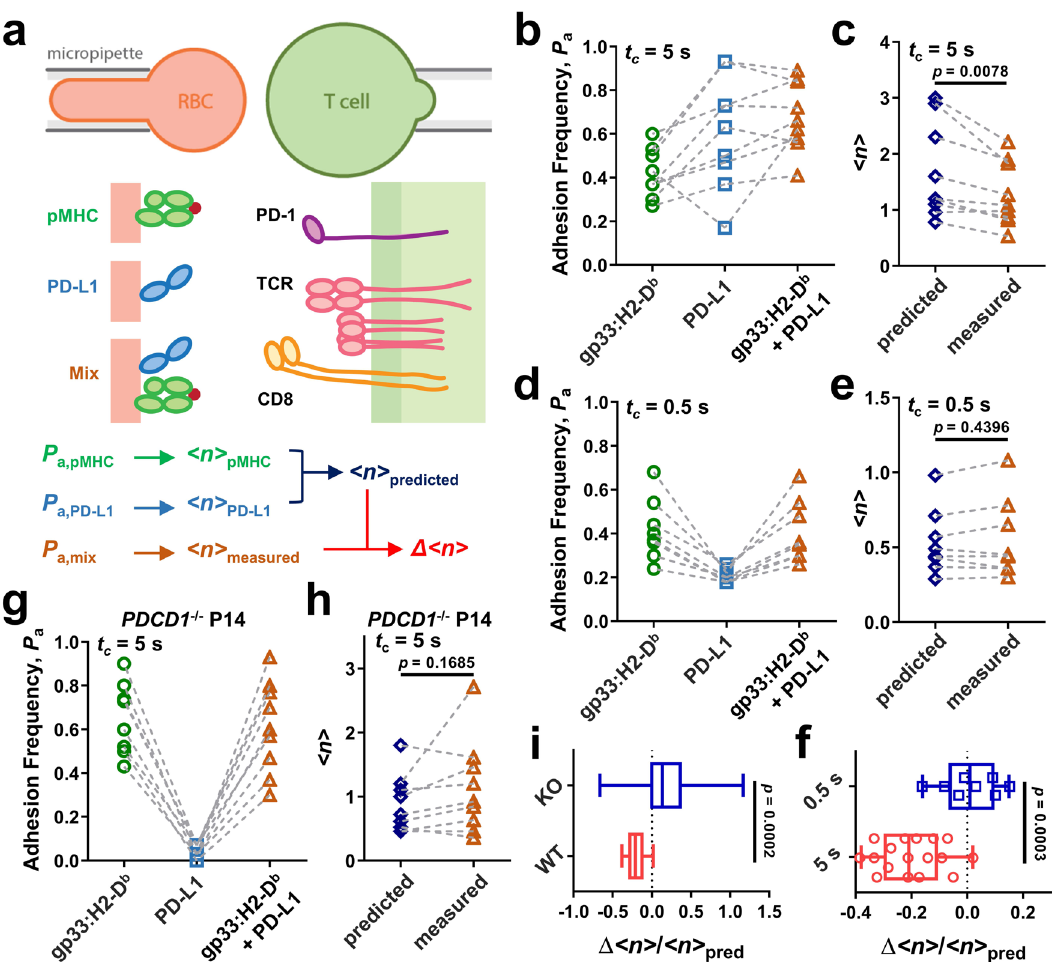
Fig. 2 2D kinetic analysis of negative cooperativity. a Schematic of the micropipette assay (top) and the molecules to be analyzed (middle). A T cell expressing TCR, CD8 and PD-1 (right) was tested against three RBCs bearing pMHC, PD-L1, or both (mix) in random order (left) to generate three adhesion frequencies ( P a ’ s), one for each RBC after 30-50 repeated touches with the T cell. The bottom row shows the work fl ow of using the three P a ’ s to determine the bond numbers (< n > ’ s) and the differential bond number ( Δ < n >). b , d Representative P a ’ s of individual in vitro activated P14 CD8 + T cells binding to RBCs coated with gp33:H2-D b , PD-L1, or both at 5-s ( b ) or 0.5-s ( d ) contact time. Data points measured by testing the same T cell against three RBCs bearing different ligands are connected by a dashed line. c , e Comparisons of predicted and measured <n > ’ s from b ( c ) and d ( e ), respectively. f Normalized change of bond number ( Δ < n >/ <n > pred ). The reduction of bond formation observed at 5-s contact tests ( n = 17 cells) was abolished when the contact time was shortened to 0.5 s ( n = 8 cells). g Representative P a ’ s of individual activated PDCD1 − / − P14 CD8 + T cells to RBCs bearing gp33:H2- D b , PD-L1, or both at 5-s contacts. h Comparison of predicted and measured <n > ’ s from g . i Δ < n > /<n > pred showing the reduction of bond formation observed when PD-1 expressing cells were used was abolished when PDCD1 − / − cells were used ( n = 16 cells). Data are presented by box-whisker plots with the center line labels median, the box contains the two middle quantiles, and the whiskers mark the min and the max. p values were calculated using paired Student ’ s t test ( c , e , h ) or Mann – Whitney test ( f , i